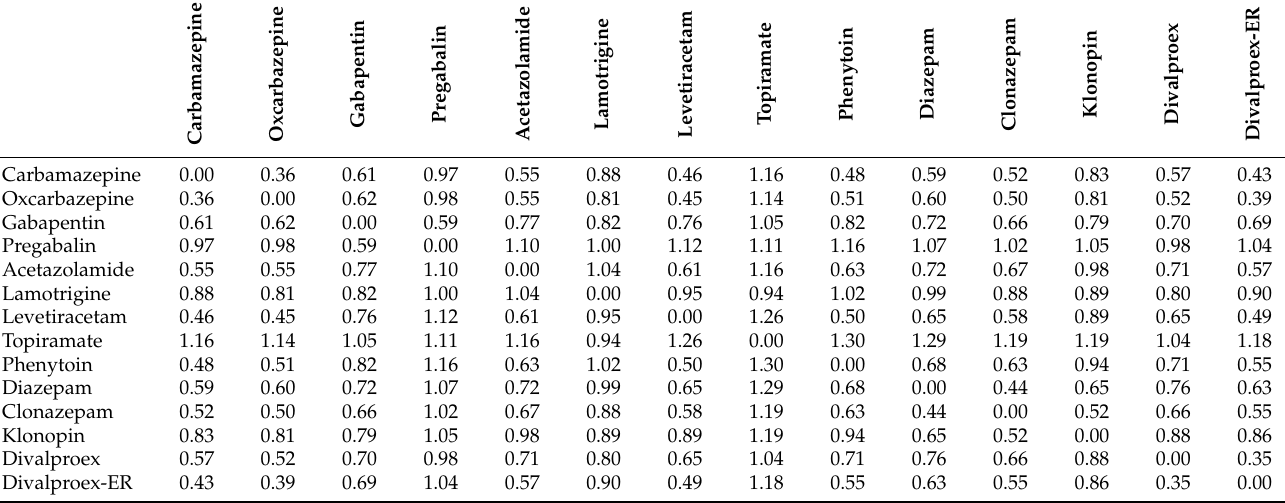
Table 3. AEDs Drug-Drug Similarity using ED